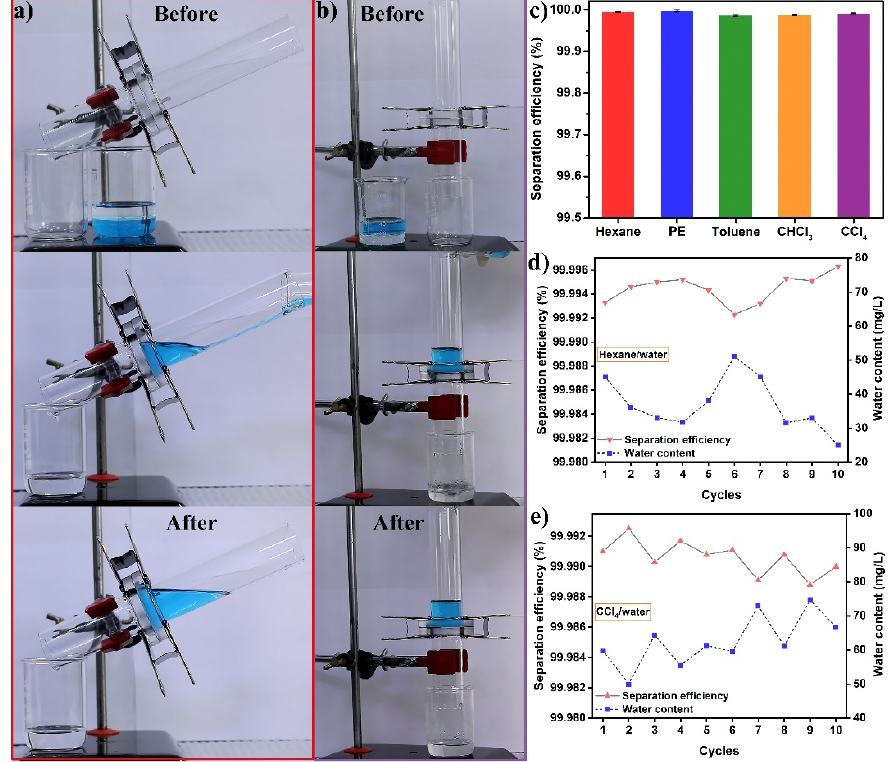
Figure 7. Separation of oil/water mixtures by the CS-coated mesh: The separation processes of ( a ) the light oil (hexane)/water mixture and ( b ) the heavy oil (CCl 4 )/water mixture. The separation efficiency and water contents of ( c ) different oil/water mixtures, and the variation of separation efficiency with ( d ) hexane/water and ( e ) CCl 4 /water separation cycles.